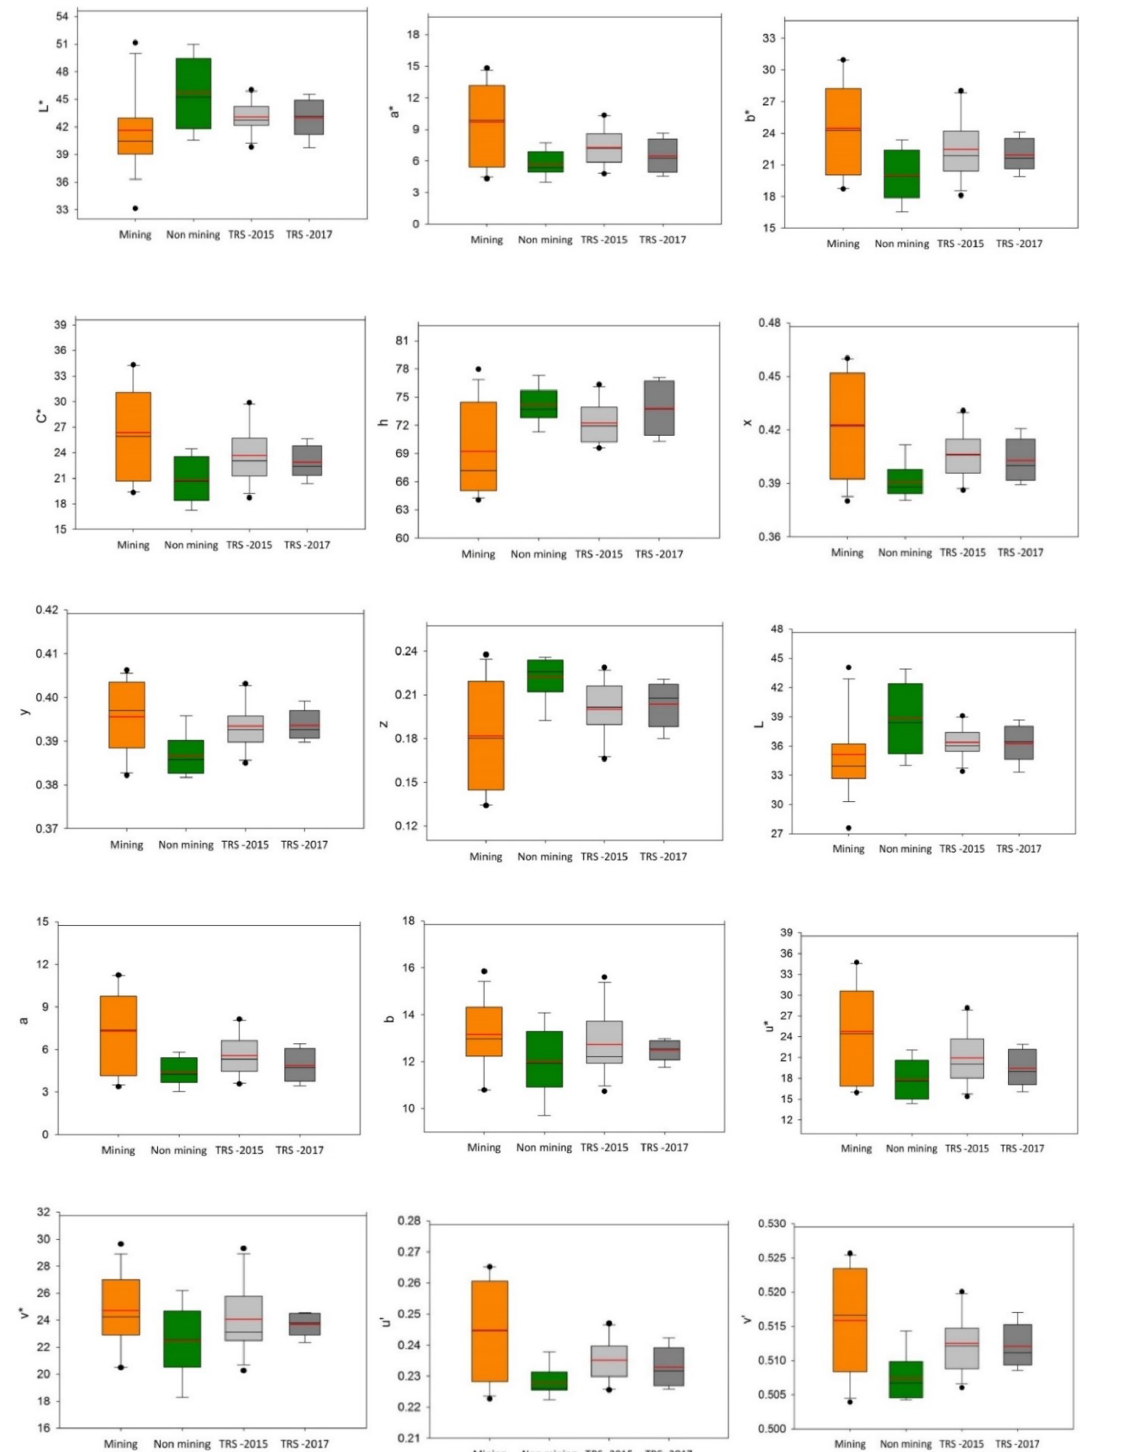
Figure 4. Box plots of colour parameter values in the < 63µm fraction of sediment collected on the mining tributaries (mining), non-mining tributaries (non-mining) and the main Thio River (Thio River sediment (TRS) flood events of 2015 and 2017). The box indicates the location of the first and third quartiles; the black line indicates the median value; the red line indicates the mean value.